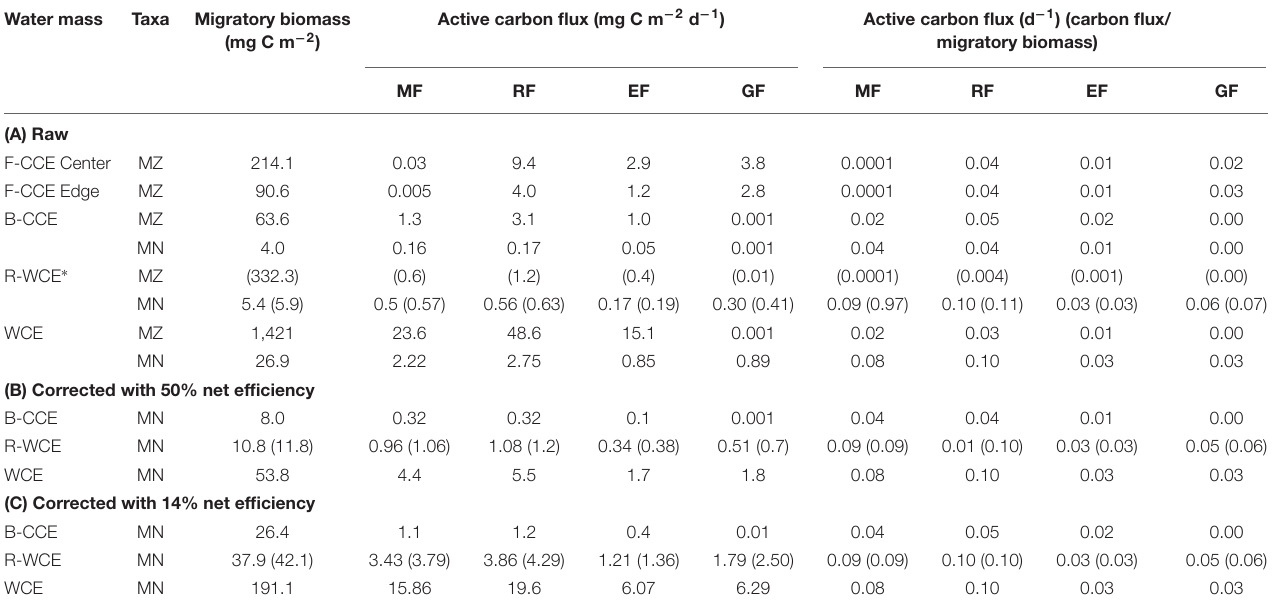
TABLE 4 | Migratory micronekton biomass (mg C m − 2 ) and active carbon fluxes (expressed in mg C m − 2 d − 1 and d − 1 ) out of the MLD in the F-CCE Center, Edge, B-CCE, and WCE, and carbon recycling in the R-WCE. Water mass